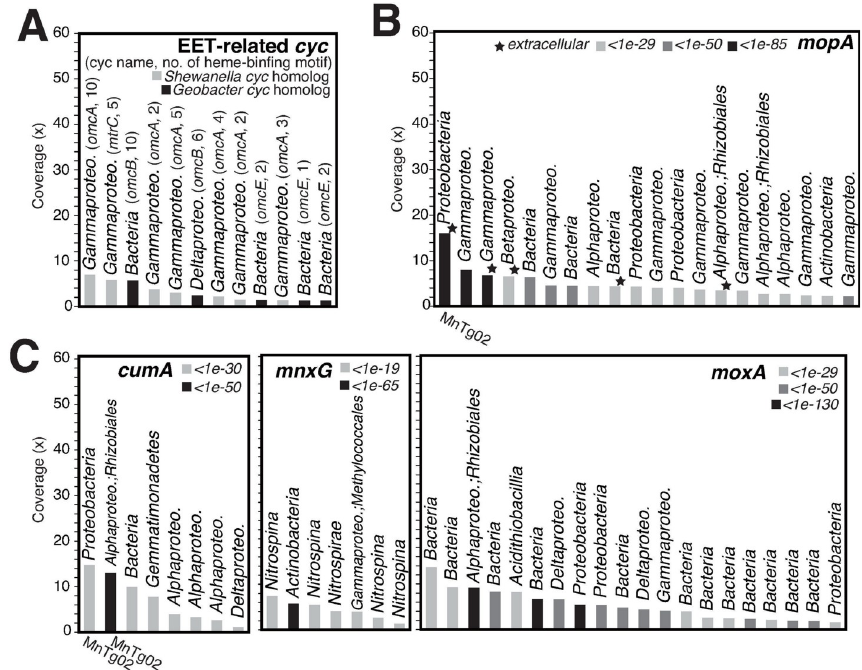
Fig 4. Read-coverage-based rank abundant plot of contigs containing CDSs potentially involved in Mn and Fe cycling. (A) CDSs for extracellular electron transfer (EET) related Cyc. The homologous gene name and the number of heme-binding motifs (CXXCH) are indicated in parentheses. CDSs for manganese oxidizing enzymes (B) MopA, and (C) CumA, MnxG, and MoxA. The threshold of BLAST e-values against the enzymes MopA of Aurantimonas manganoxydans SI85-9A1 (WP_009209951), CumA of Pseudomonas putida GB-1 (Accession no. AAD24211), MnxG of Bacillus sp. SG-1 (AAB06489), MoxA of Pedomicrobium sp. ACM 3067 (CAJ19378) are shown by the colors of the bars. The IDs of metagenome-assembled genomes (MAGs) are shown for the contigs containing CDSs identical to those of the MAGs.